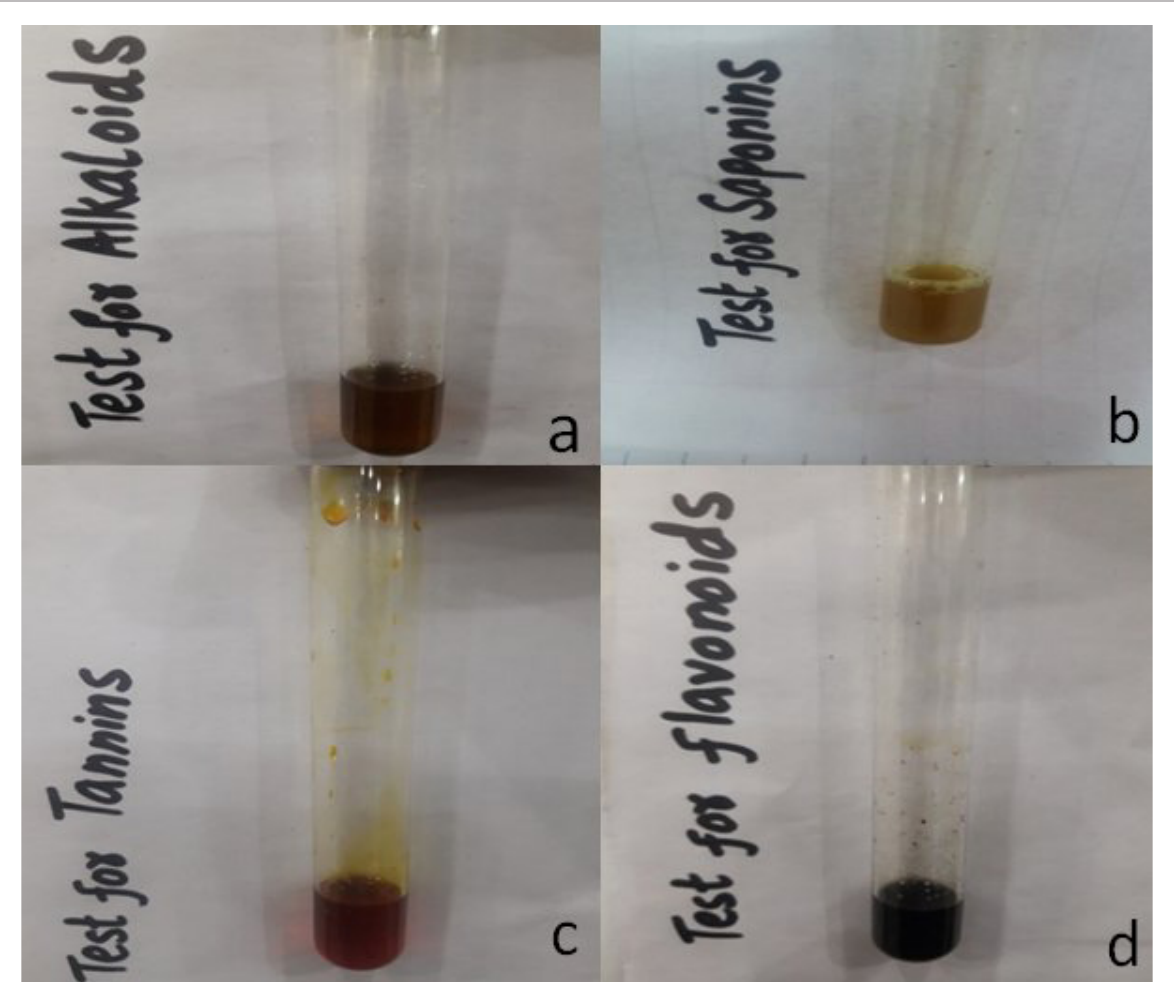
FIGURE 1 - Phytochemical screening of ethanolic extract of Catharanthus roseus leaves Ethanolic extract. a: Wagner’s test; dark brown color precipitates indicated for alkaloids b: Foam test; Froth indicated for saponins c: Potassium dichromate test; dark color indicated for tannins. d: Ferric chloride test; Intense green color indicated for